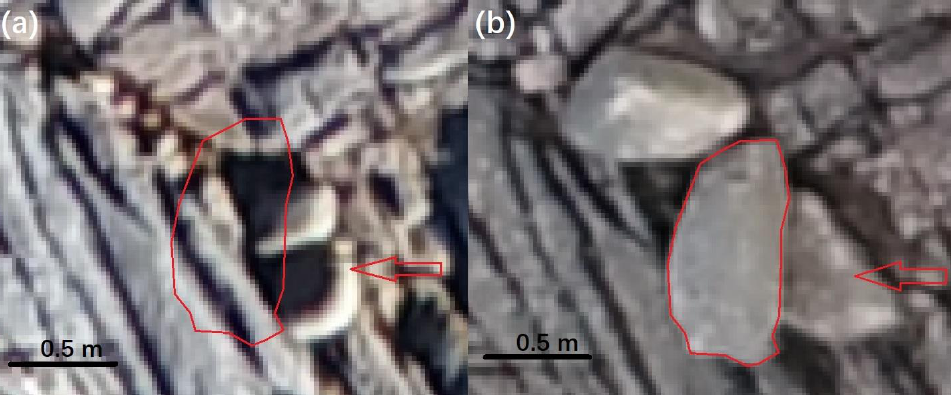
Figure 12. An example of surface changes, where boulders in 2017 ( a ) moved away and new boulders moved in by 2018 ( b ), meaning that the surface beneath the boulders was not acquired in either survey.